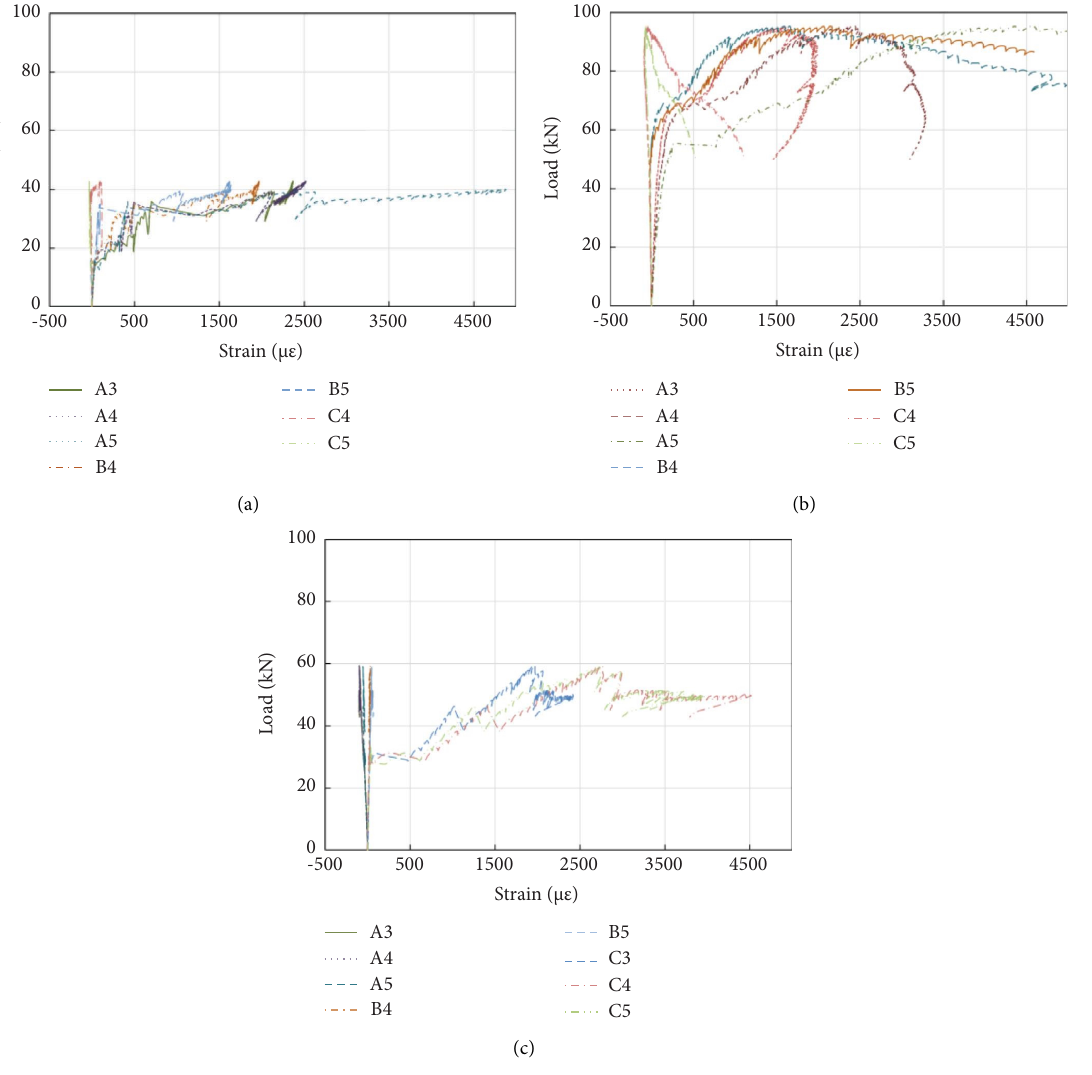
Figure 8: Typical load-strain curves of longitudinal reinforcement at the mid-span. (a) Specimen G24-I, (b) specimen G24A0.2-I, and (c) specimen